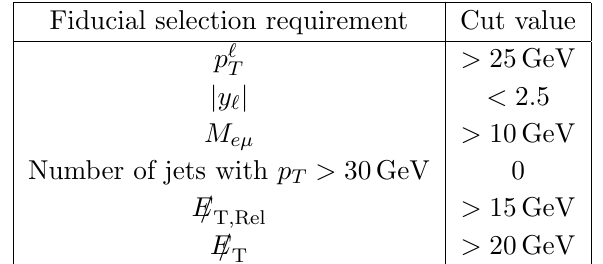
; y ‘ are the transverse momen- T is de(cid:12)ned in eq. T ; Rel